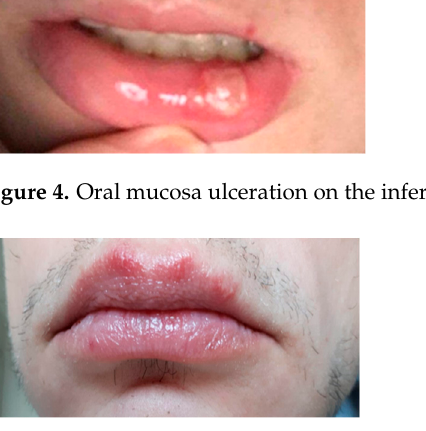
Figure 5. Herpes simplex lesions on the upper lip affecting a 17-year-old boy.